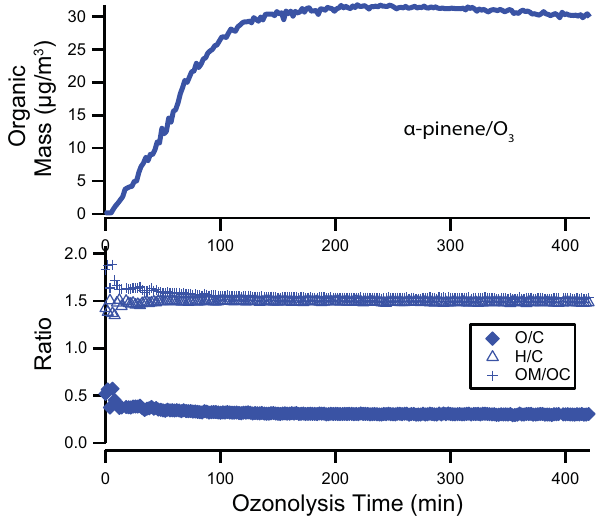
Fig. 3. AMS organic mass (not corrected for collection efficiency) O/C, H/C and OM/OC ratios for a typical α -pinene ozonolysis ex- periment (Experiment 4).